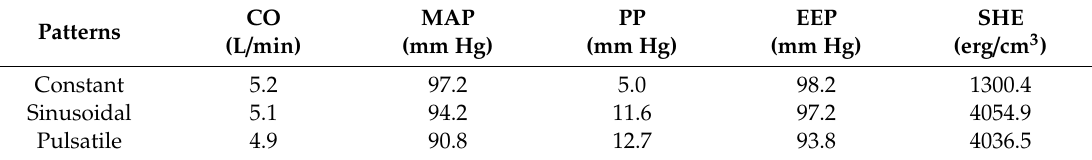
Table 4. Cardiac output indicators under di ff erent speed patterns of the blood